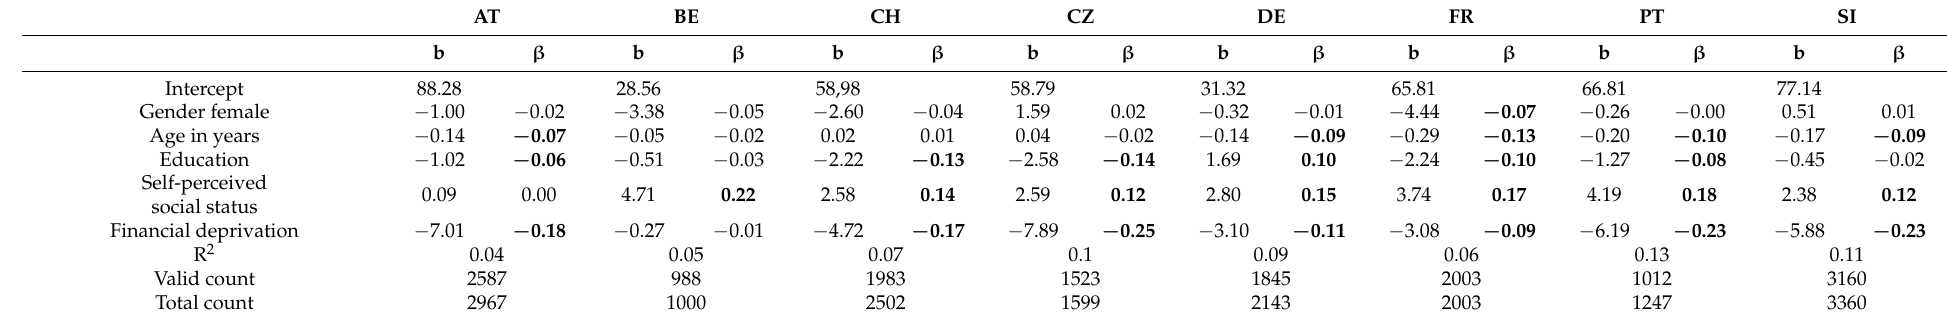
Table 9. Multivariable linear regression models of NAV-HL score (dependent variable) by social determinants (independent variables) for total samples in countries (equally weighted) (mainly taken from HLS 19 Consortium [17] (p. 217)).